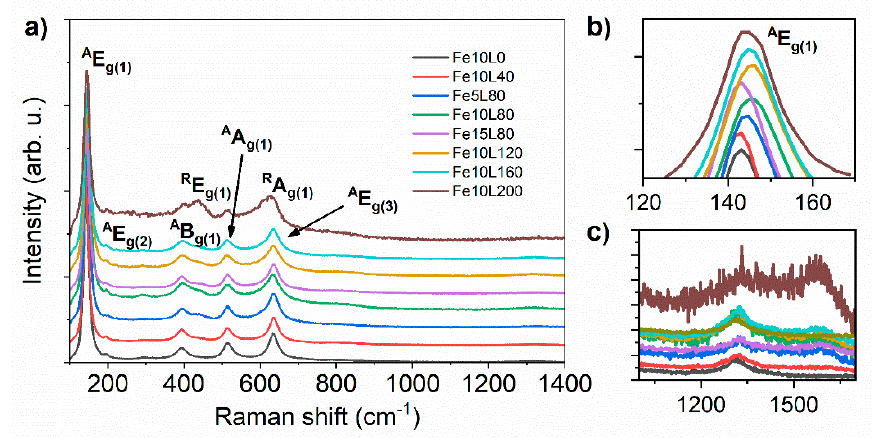
Figure 5. ( a ) Raman shift spectra recorded for laser-modified Fe-decorated TiO 2 -NTs. ( b ) The magnification of the anatase E g(1) . ( c ) Magnon scattering peaks.